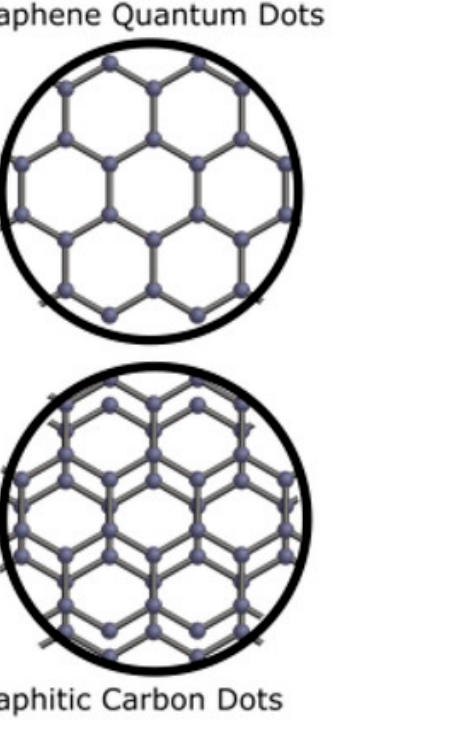
Figure 2. Schematic illustration of reported four types of CNSs. Black and red dots represent carbon and nitrogen atoms, respectively. Reprinted with permission from [4], MDPI 2018.